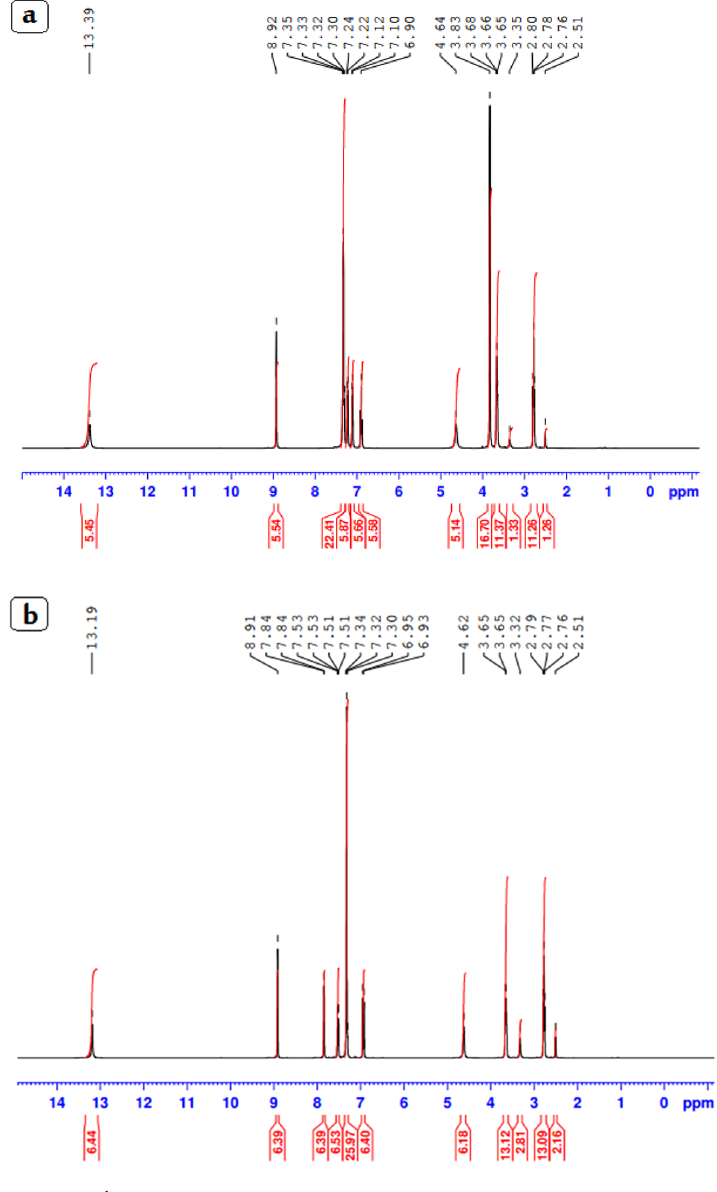
Figure 1. 1 HNMR spectra of HL1 ( a ) and HL2 ligands ( b